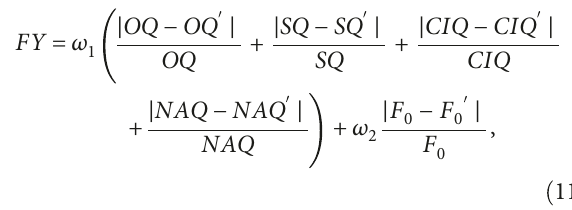
n by iterative fi g